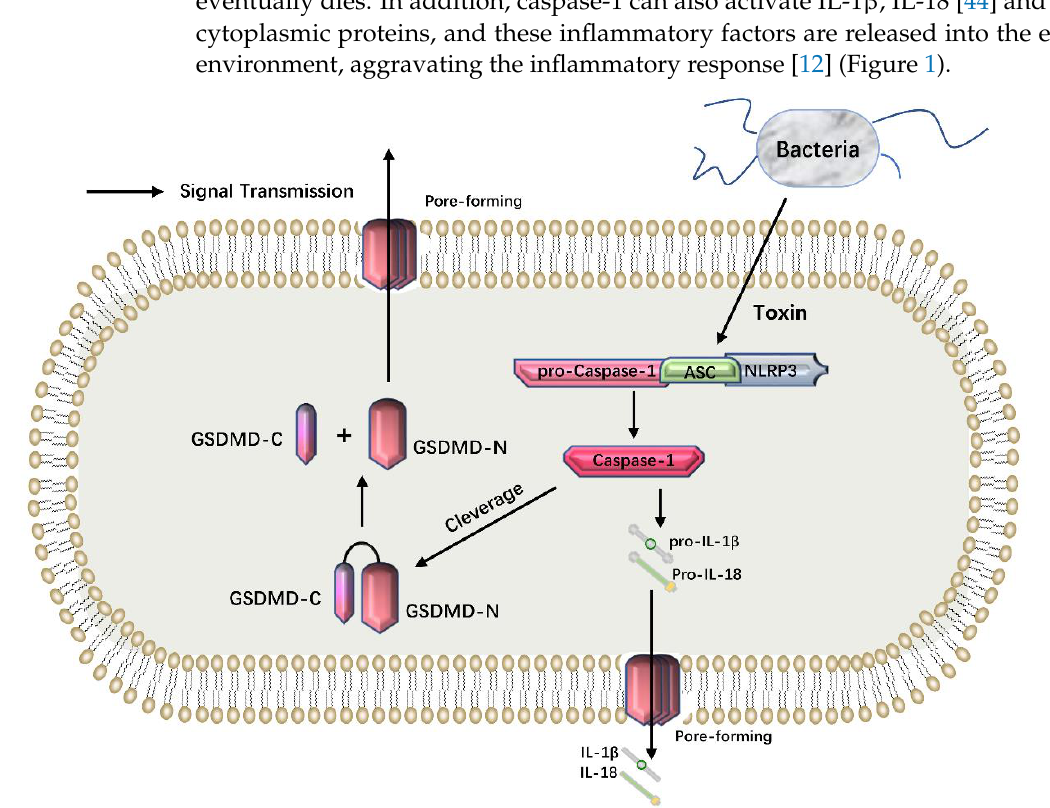
Figure 1. The canonical pyroptosis pathway. PAMPs are recognized by PRRs and form inflammasome complexes, in which NLRP3 is the representative. The inflammasome activates and cleaves pro-caspase-1 into caspase-1 through the adaptor protein ASC, which cleaves GSDMD into an N-terminal domain (GSDMD-N) with perforating activity. GSDMD-N forms non-selective oligomeric pores in the plasma membrane through membrane-lipid interactions. The cells died because of water influx, swelling and rupture. In addition, caspase-1 can also activate inflammatory cytokines like IL-1 β and IL-18 which are released into the extracellular fluid via membrane pores and exacerbate the inflammatory response.